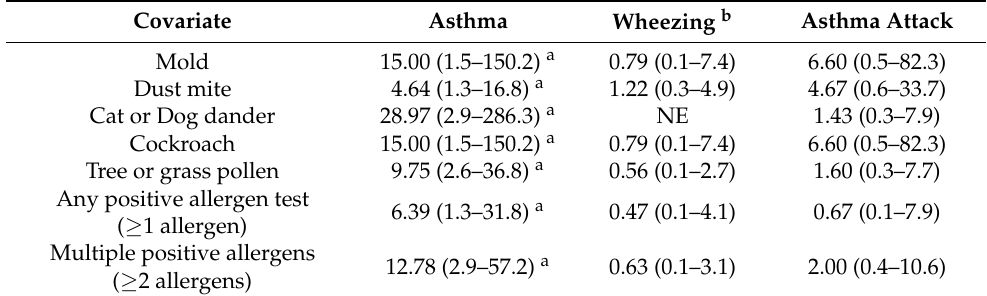
Table 3. Odds Ratio (95% confidence interval) of asthma prevalence, asthma attack and wheezing with respect to positive testing for different environmental allergens.